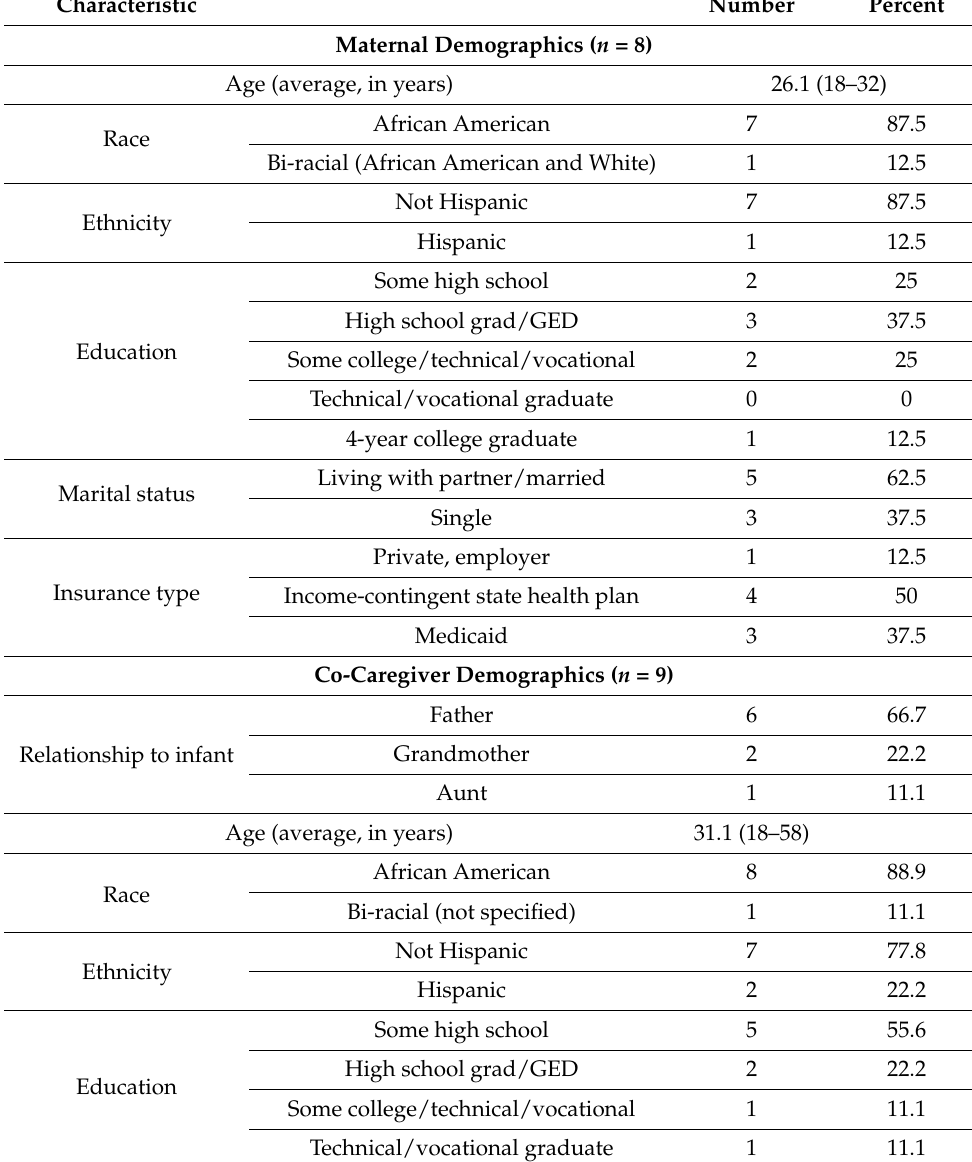
Table 2. Demographics of study sample ( n =